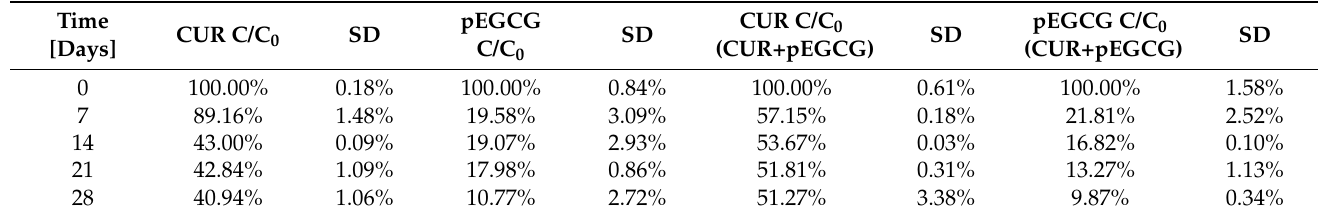
Table 4. Changes in the concentration of CUR and pEGCG in liposomal nanoformulations in the stability study at refrigerator temperature (4–8 °C).